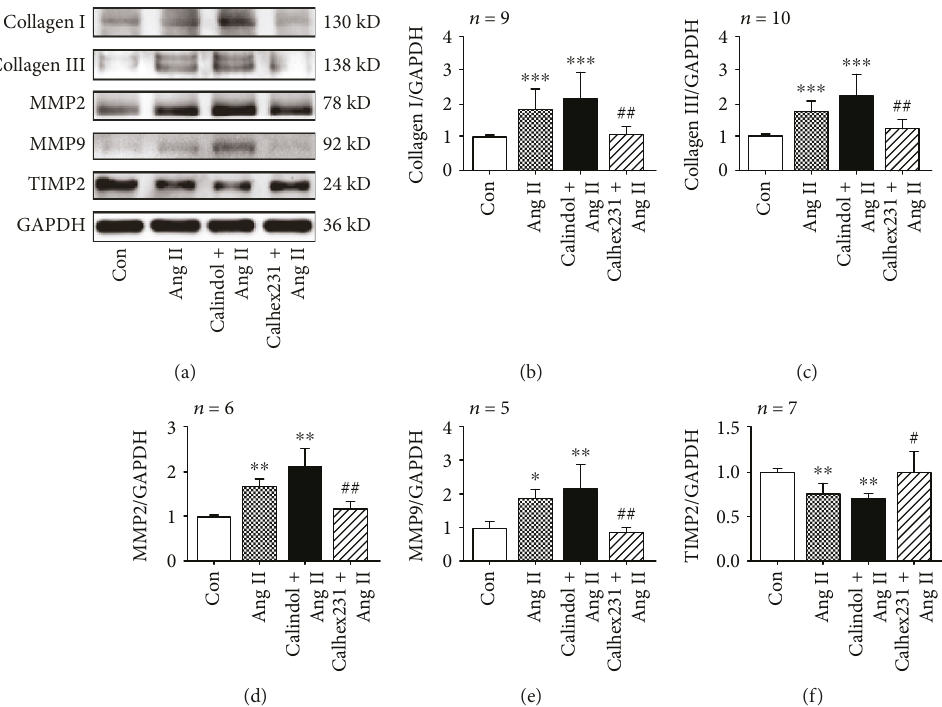
Figure 5: Calhex 231 suppressed collagen synthesis in VSMCs cultured with Ang II. (a) Western blots of collagen I, collagen III, MMP2, MMP9, and TIMP2 expressions. (b – f) Quantitative analysis of the proteins from A. ∗ P < 0 05 , ∗∗ P < 0 01 , and ∗∗∗ P < 0 001 vs. control; # P < 0 05 and ## P < 0 01 vs. Ang